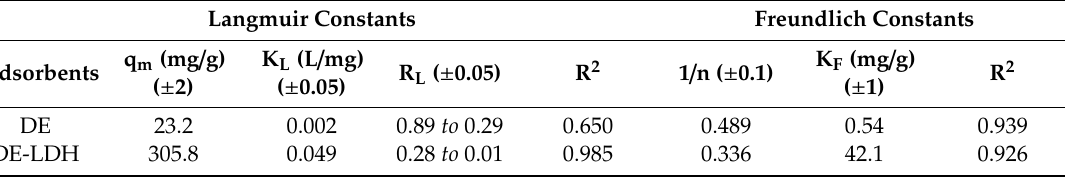
Figure 7. Adsorption isotherm plots of CR on DE and DE-LDH. Table 2. Adsorption isotherm parameters for adsorption of CR onto DE and DE-LDH.